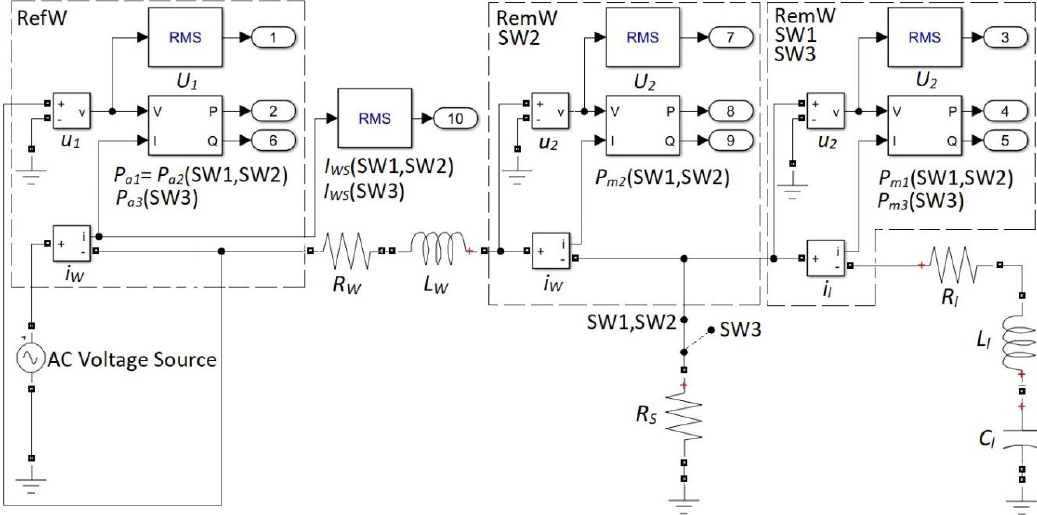
Figure 6. Simulink model for evaluation of objective and constraint functions.